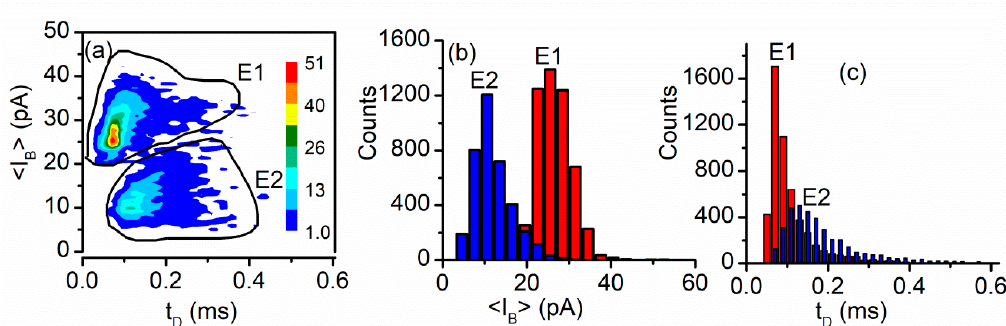
Figure 20. Event analysis for Ang II translocation. ( a ) The density plot shows two well-defined clusters of recorded events; the color map indicates event density; ( b ) The current blockage distribution shows a good separation between the two types of events; ( c ) The distribution in terms of dwell type between the two types of events indicates overlapping and poor separation. Published under Creative Commons Attribution License in [29].